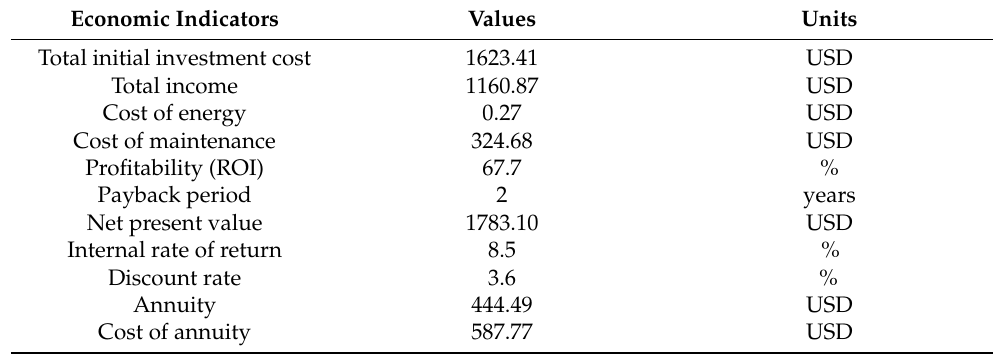
Table 5. Study’s economic